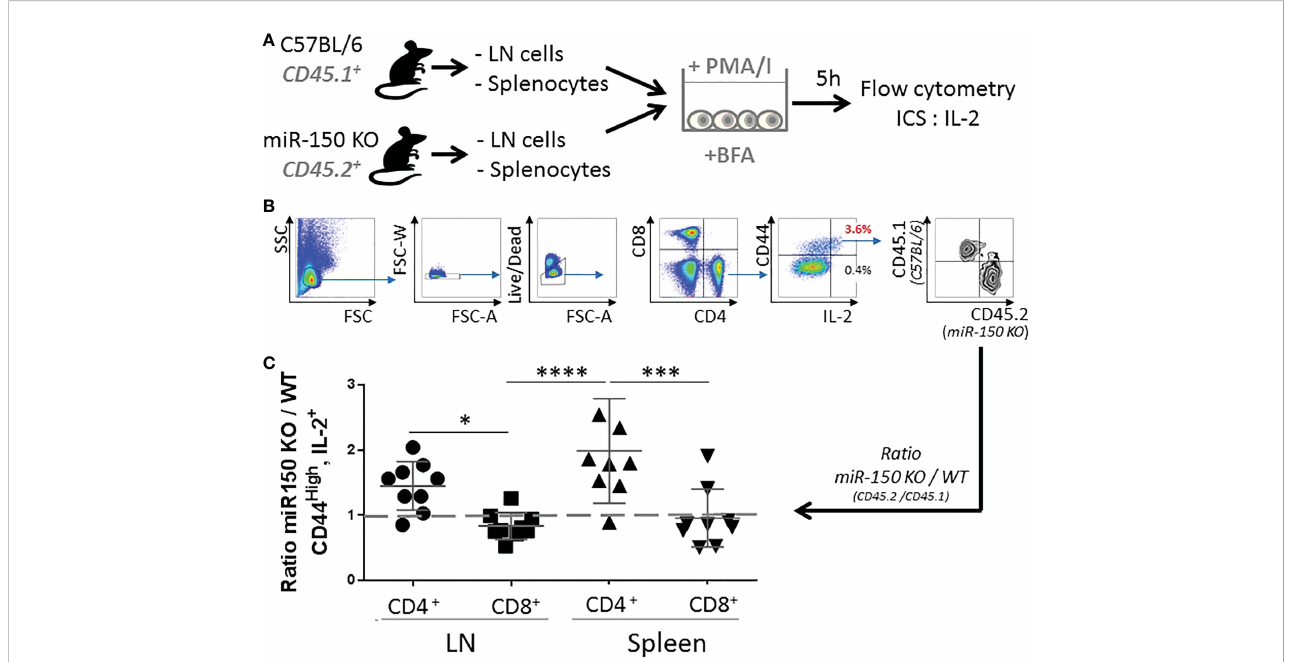
FIGURE 3 miR-150 controls IL-2 production in CD4 + but not CD8 + T cells. (A) Naïve splenocytes and naïve lymph node cells from miR-150-KO (CD45.2 + ) and WT (CD45.1 + ) mice were co-cultured and stimulated with PMA and Ionomycin (PMA/I) for 5 h in the presence of Brefeldin A (BFA) then analyzed by fl ow cytometry. (B) Cells were analyzed by fl ow cytometry and gated as single, live, CD4 + or CD8 + , CD44 + , and IL-2 + cells. (C) Ratio of miR-150-KO/WT of activated cells expressing IL-2 is shown. Data were combined from 3 independent experiments, n=9 per group. Each dot represent individual biological replicates +/- s.e.m. Statistical signi fi cance was evaluated by two-way ANOVA. (*p < 0.05, ***p < 0.001; ****p <